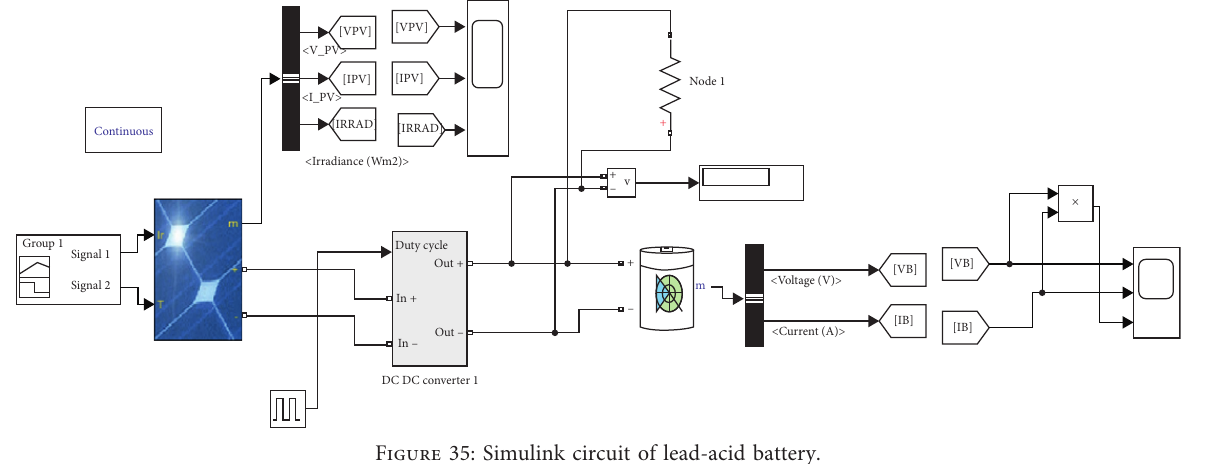
Figure 35: Simulink circuit of lead-acid battery.